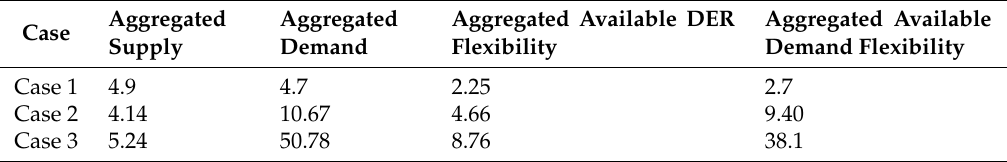
Table 2. Overview of the case studies. The values are in per unit (p.u.) with 100 MVA base. Case